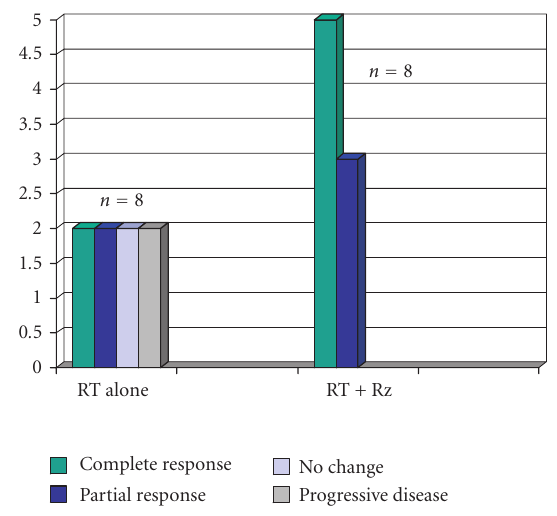
Figure 1: Response of 16 assessable liposarcomas randomized be- tween radiotherapy (RT) alone and together with razoxane